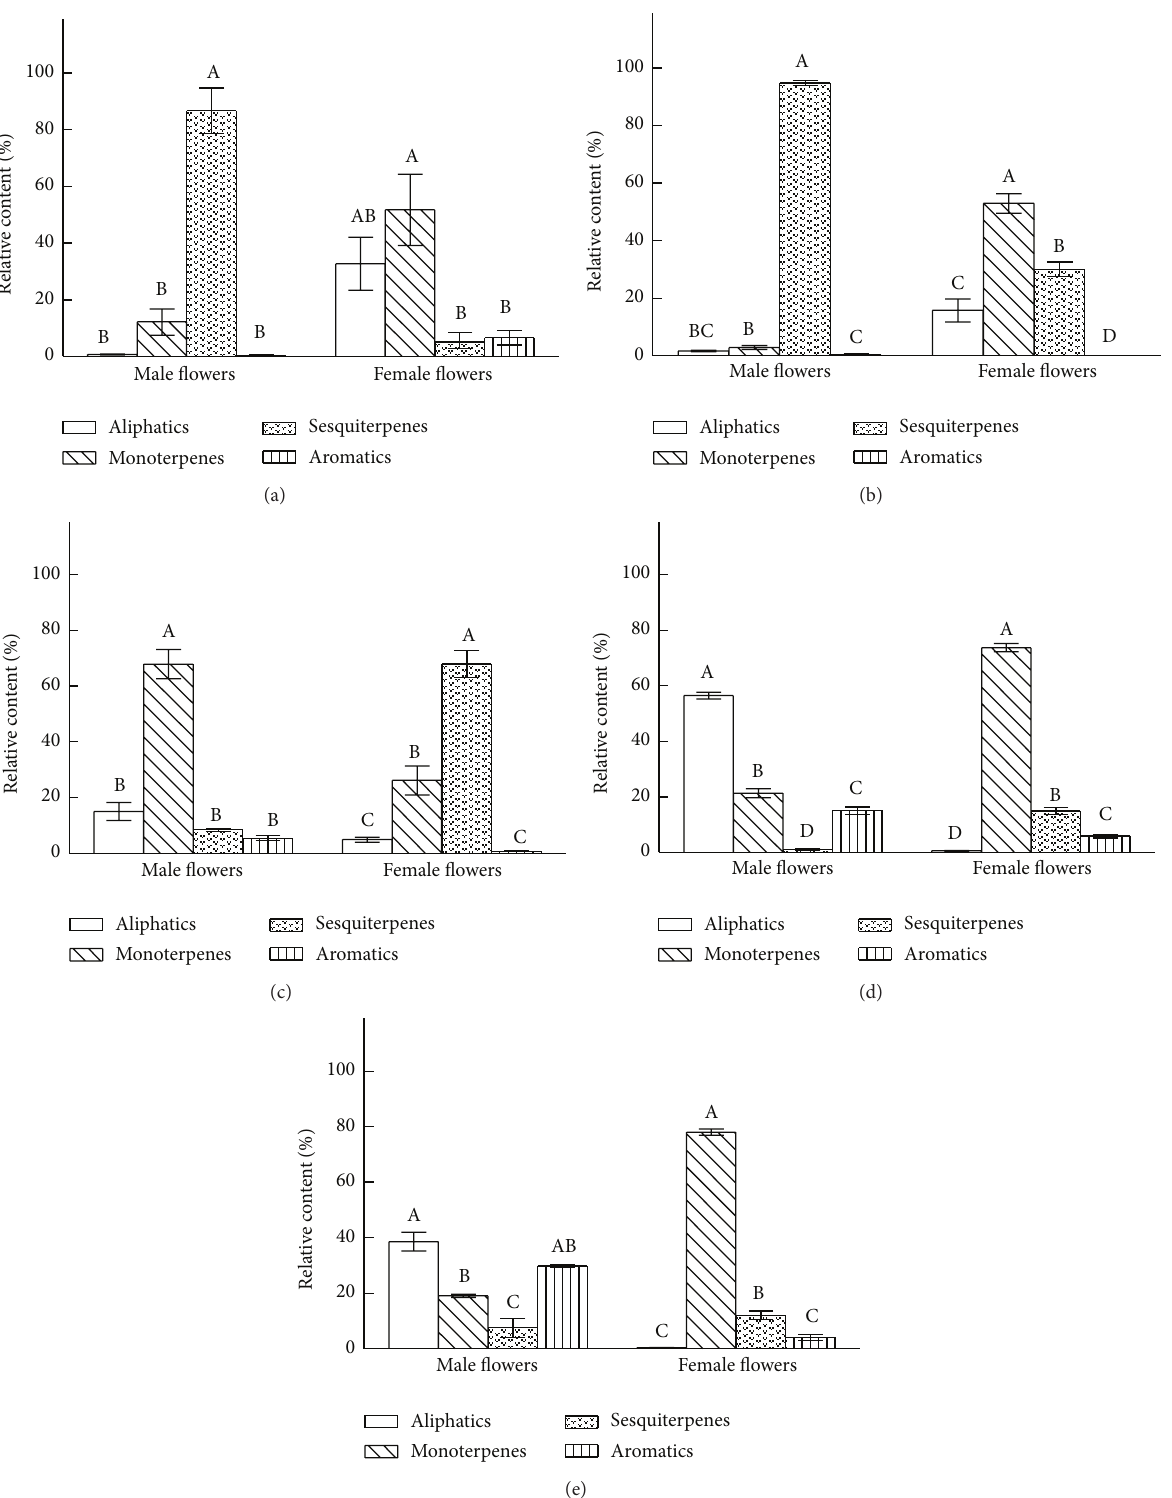
Figure 3: Relative amounts (%) of four chemical classes volatile compound of both male and female flowers from five Glochidion species. (a) G . eriocarpum ; (b) G . daltonii ; (c) G . sphaerogynum ; (d) G. hirsutum ; (e) G. zeylanicum (one-way ANOVA: the different lowercase letters on the bars indicate significant difference at 𝑃 = 0.05